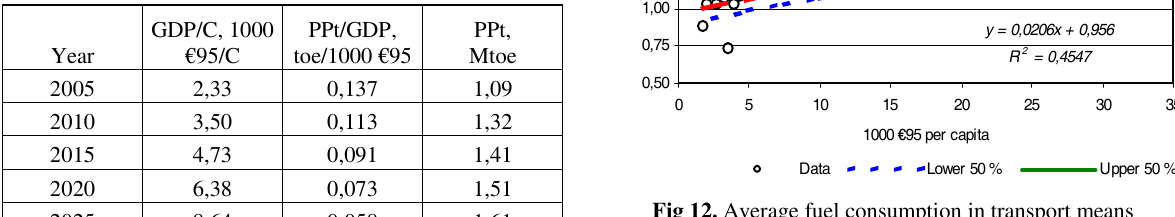
Fig 10. Dependences of intensity consumption of petroleum in road transport on GDP per capita in EU ( 6061,0 2061,0 − = xy ) and Lithuania ( 7311,0 2674,0 − = xy Table 2. Forecasts of fuel consumption in road transport (basic scenario) by intensity approximation function